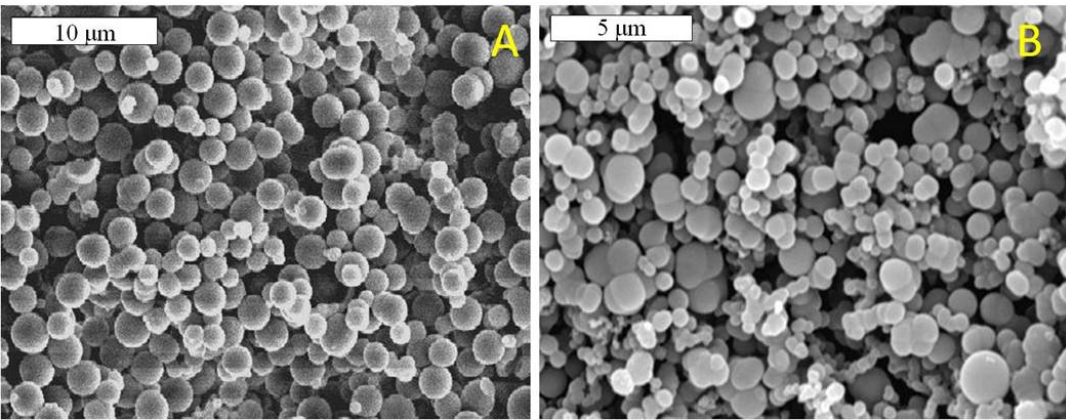
Figure 3. Scanning electron microscopy (SEM) images of the core-shell microcapsules. ( A ) Core-shell microcapsules with oil interior created by coating oil-in-water emulsion droplets with CaCO 3 using the PILP process. Their diameters range from 2 to 4 µm in this batch. ( B ) Core-shell microcapsules with aqueous interior created by coating liposome vesicles with CaCO 3 using the PILP process. Their diameters are distributed below 2 µm. Both emulsion and liposome-derived microcapsules are slightly larger than the emulsion droplets and liposomes alone due to the ~500 nm thickness of the applied mineral coating.